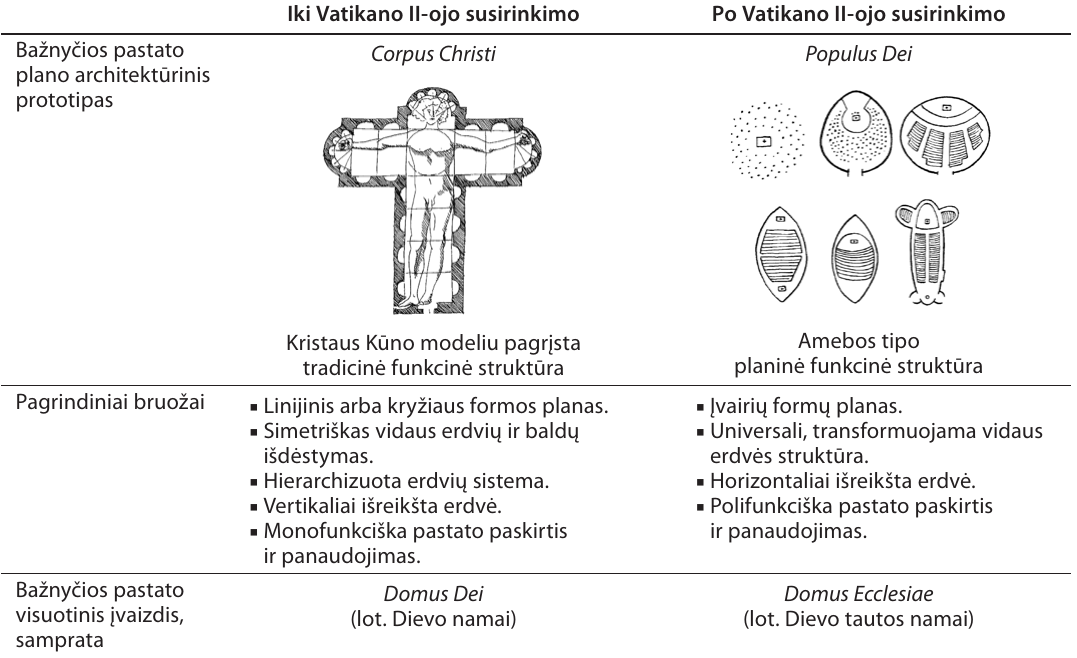
Table 1. Church paradigms shift and it‘s disparity in the 20 century Iki Vatikano II-ojo